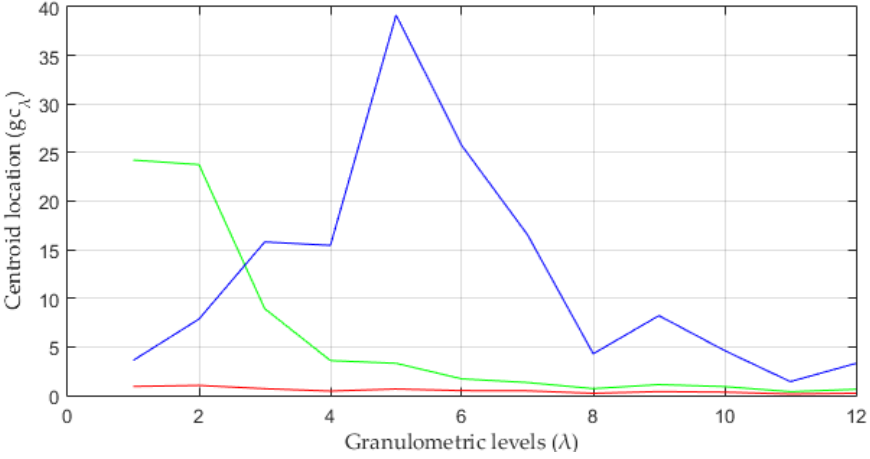
Figure 5. Granulometric profiles of 3 classes from 12 granulometric levels. Guileyni, 2011.